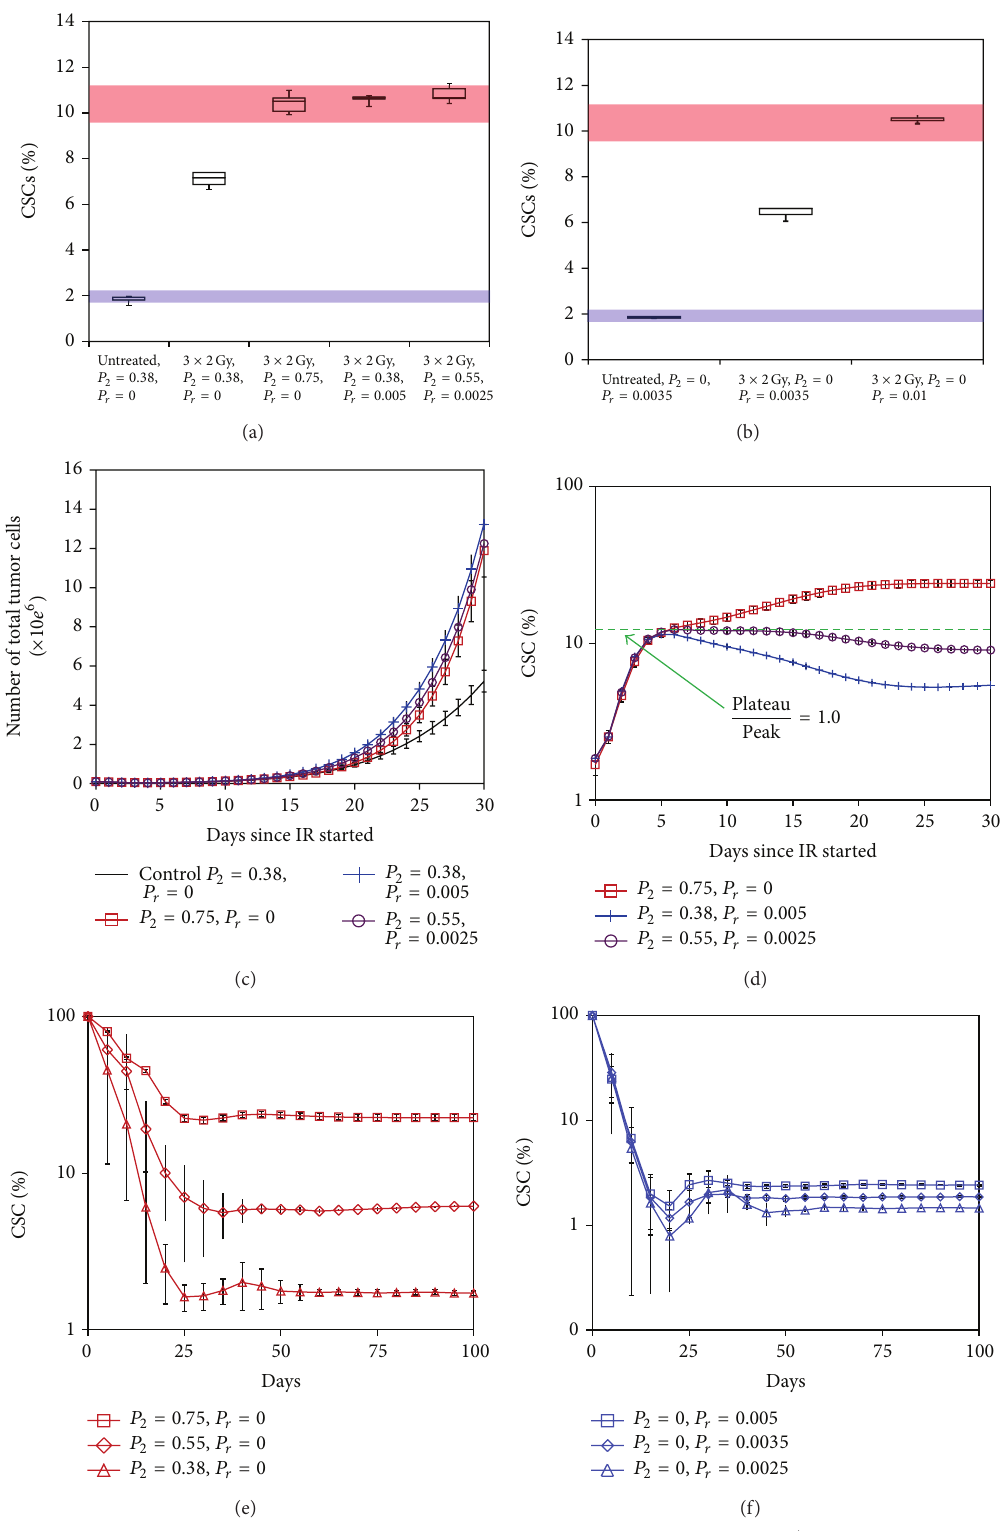
Figure 1: The bottom and top transparent regions in (a) and (b) represent the percentages of CD133 + subpopulation in the U87-MG cell line before and after fractionated irradiation ( 3 × 2 Gy), respectively [8]. (a) CSC fraction in silico after fractionated irradiation ( 3 × 2 Gy) under different mechanisms (means ± SD, 𝑛 = 5 ). (b) The CD133 + fraction observed in the U87-MG population before and after fractionated irradiation can also be reproduced in silico by applying an induced reprogramming rate. In silico tumor regrowth dynamics for different rates of symmetric divisions and reprogramming: (c) total tumor cell number and (d) percentage of CSCs. Tumors initiated by a single surviving CSC maintain a steady proportion of CSCs under either (e) a constant symmetric division rate or (f) a constant cell reprogramming